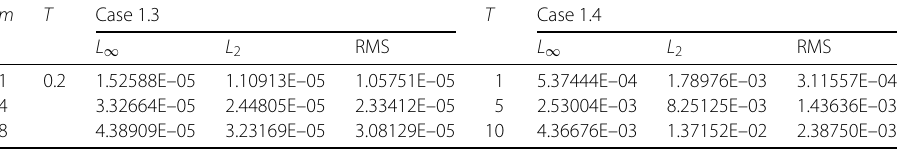
Table 6 Error norms of Example 1 using regular